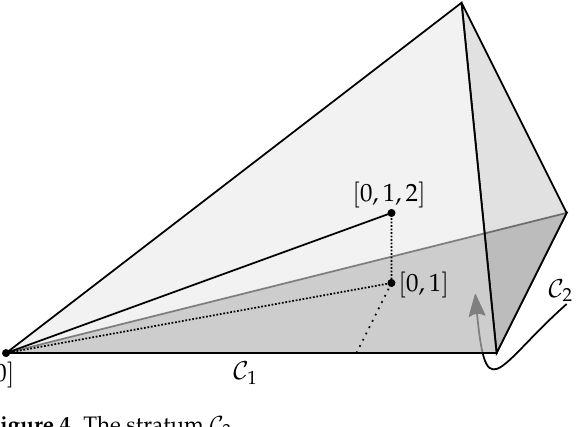
Figure 4. The stratum C 3